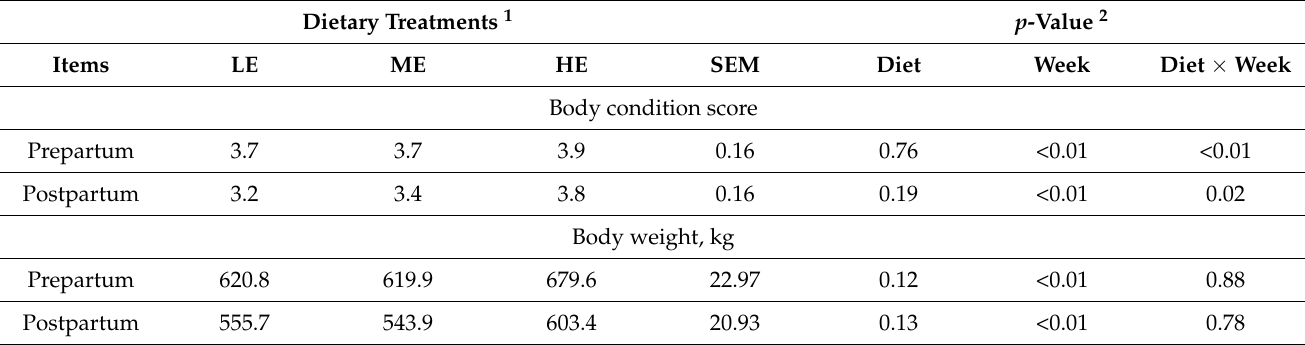
Table 3. Body condition score and body weight of Nili Ravi buffaloes fed different levels of energy. Dietary Treatments